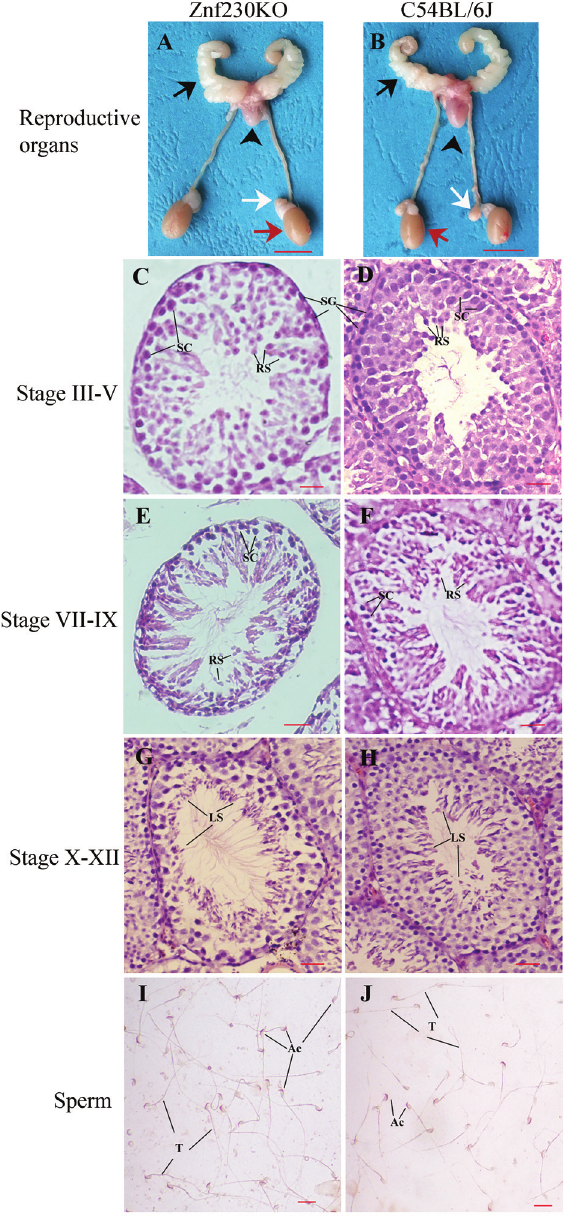
Figure 3 - Characteristics comparison of reproductive organs and sperm shape between Znf230 KO and C57BL/6J mice. Morphology of reproduc- tive organs from Znf230 KO (A) and C57BL/6J (B) mice. The seminal vesicles(blackarrows),bladder(blackarrowheads),epididymis(whitear- rows) and testes (red arrows) were highlighted. Scale bar = 1 cm. Histological analysis of H&E stained testes from Znf230 KO (C,E,G) and C57BL/6J (D,F,H) mice. SG: Spermatogonia, SC: Spermatocyte, RS: Round spermatids, and LS: elongated spermatids. Scale bar = 100 (cid:2) m. Characteristics of H&E stained sperm from Znf230 KO (I) and C57BL/6J (J) mice.. Ac: acrosome, T: sperm tail. Scale bar = 50 (cid:2) m.